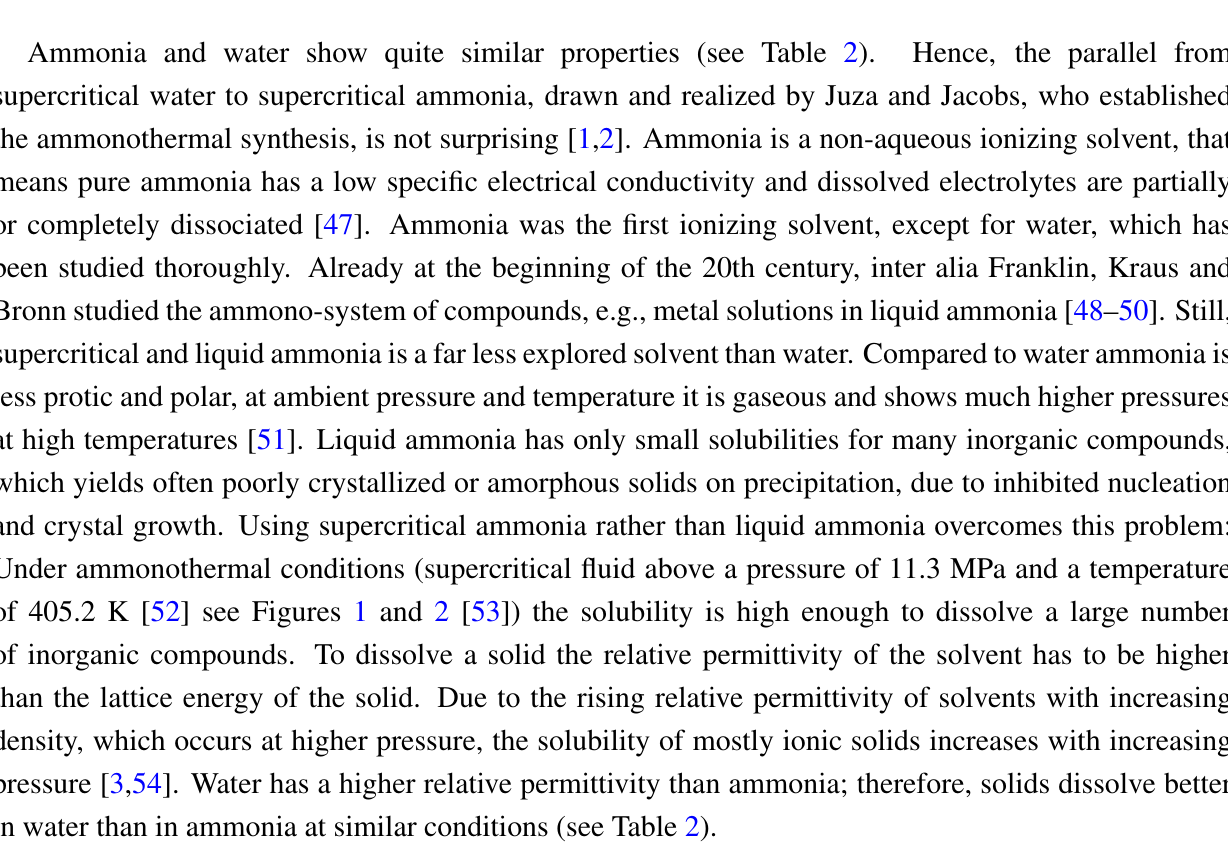
Table 2. Comparison of selected properties of ammonia and water